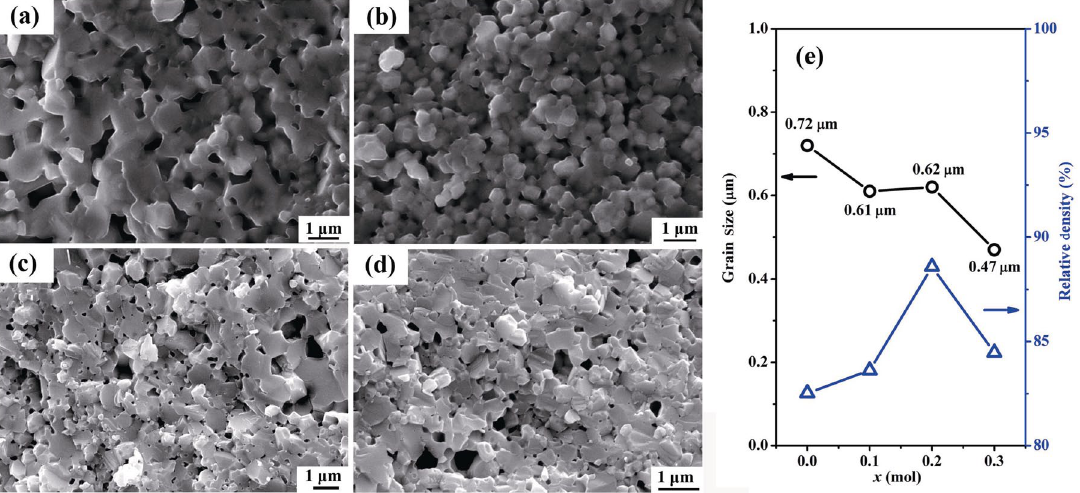
Fig. 5 FESEM images of the fractured surfaces and relative densities for the bulk samples with the mole ratio of (1– x )CuSbS 2 – x Cu 1.8 S ( x = 0, 0.1, 0.2, 0.3): (a) x = 0, (b) x = 0.1, (c) x = 0.2, (d) x = 0.3, and (e) grain size and relative